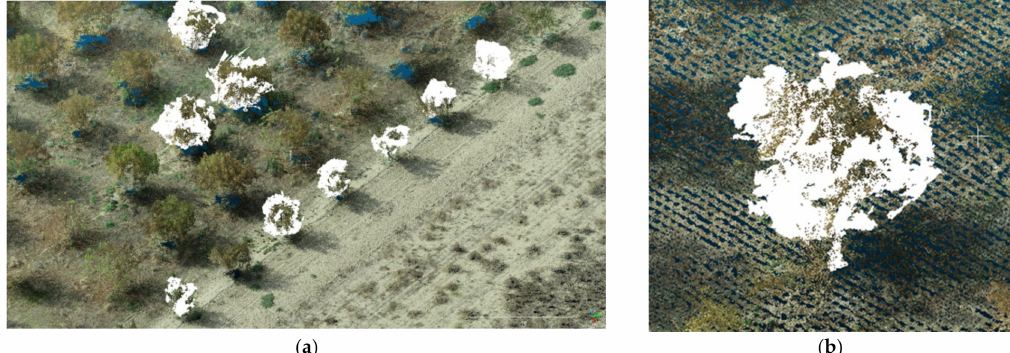
Figure 9. The 3D projection of the point clouds exported with the two methods used in the study; the ground-based system using depth camera mounted on Thorvald UGV (( a ), white dots) and the orthomosaic exported from aerial images acquired using UAV (( b ), colored